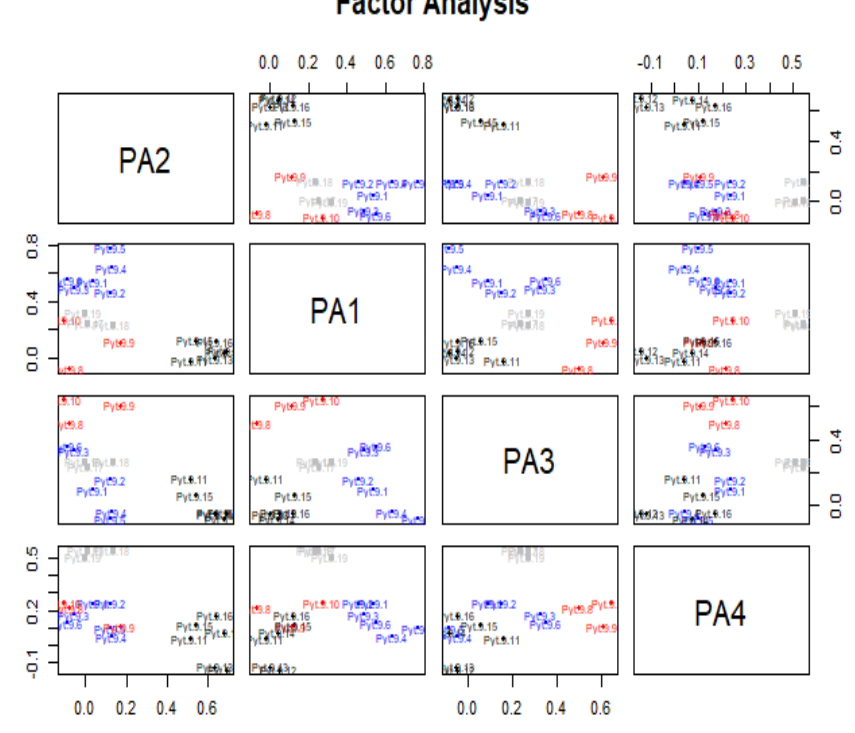
Figure 2. Reduced matrix of correlations. Source: based on own research. The review of the results began with an assessment of eigenvalues. For the four vari‑ ables, the cumulative percentage of explained variance of the analysed variables was 83%, and no further variable explained more than 5% of the variance. A quartimax orthogonal